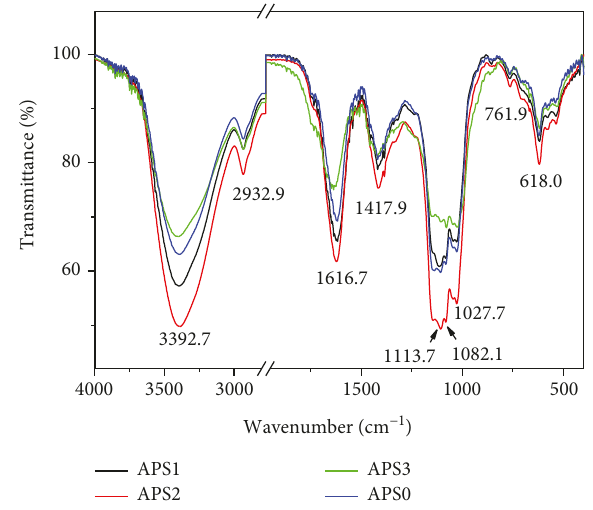
Figure 1: Infrared spectrum of APS with di ff erent molecular